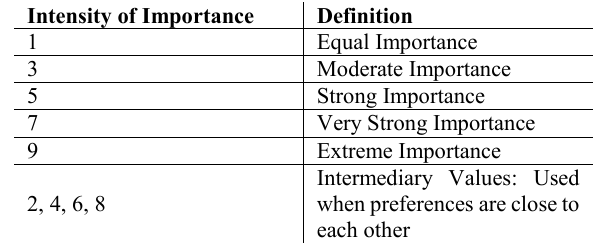
Table 2. Scale for binary comparison in